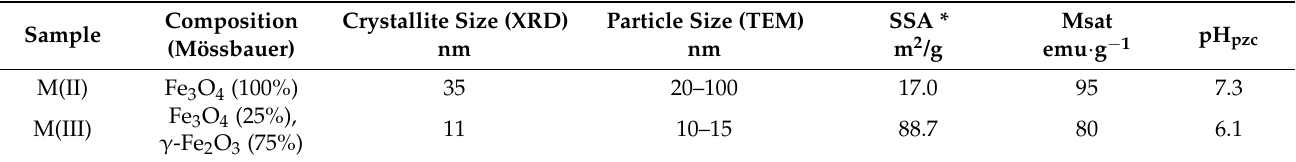
Table 1. Main properties of synthesized magnetic iron oxide nanoparticles.